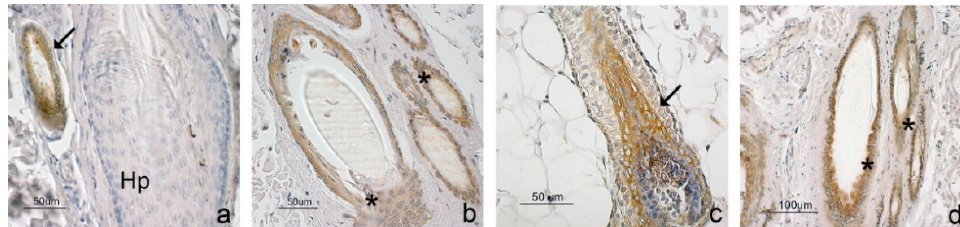
Figure 3. Immunostaining for ADIPOQ ( a ), ADIPOR1 ( b , c ), and ADIPOR2 ( d ) in primary and secondary hair follicles. ( a ) An ADIPQ-negative hair follicle (Hp) is close to an ADIPOQ-positive sebaceous gland (arrow). ( b ) A group of hair follicles positive to ADIPOR1. Staining is localized in the outer root sheath cells (asterisk). ( c ) A hair follicle bulb where the ADIPOR1-positive inner root sheath (arrow) is shown. ( d ) A group of hair follicles positive to ADIPOR2. Positivity can be observed in the outer root sheath cells (asterisk).